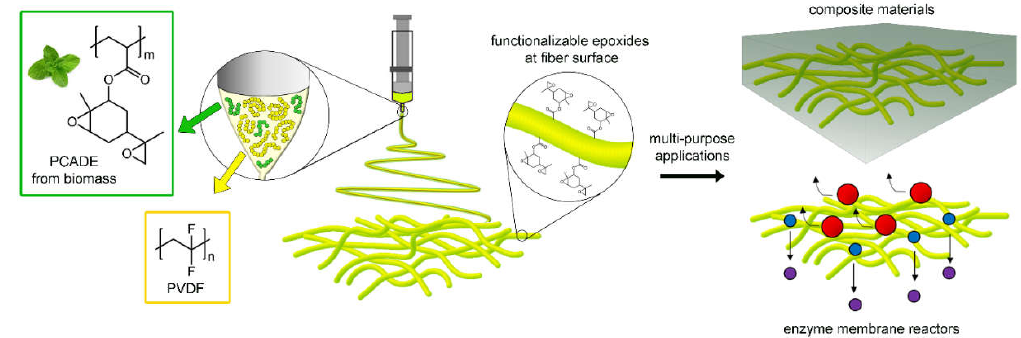
Figure 1. PCADE and PVDF were blended in a common solution and electrospun to produce fibres with an epoxy-rich surface. Different PVDF/PCADE fibres were tested in epoxy CFRP and for enzyme immobilisation.